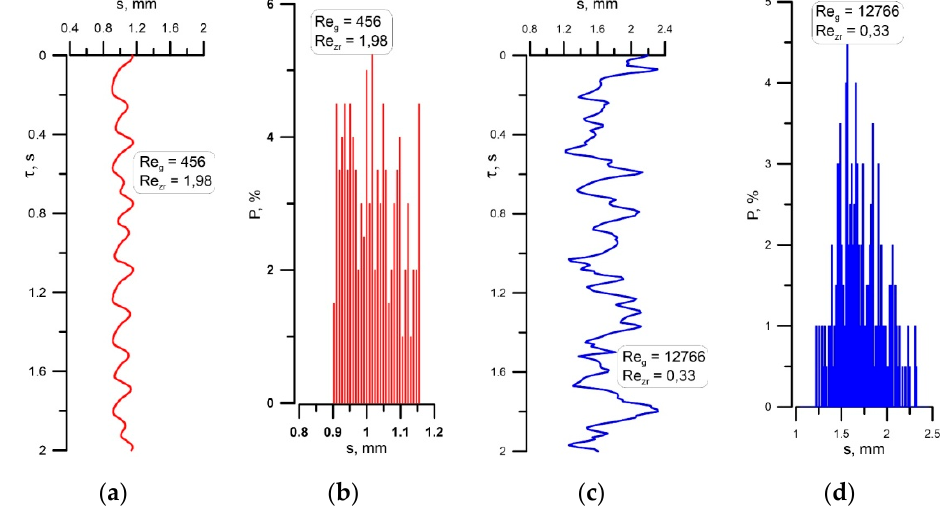
Figure 5. Results of studies and calculations of the condition of liquid film thickness and its distribution. ( a ), liquid film thickness for Re g = 456; ( b ), distribution thickness for Re g = 456; ( c ), liquid film thickness for Re g = 12766; ( d ), distribution thickness for Re g = 12766.